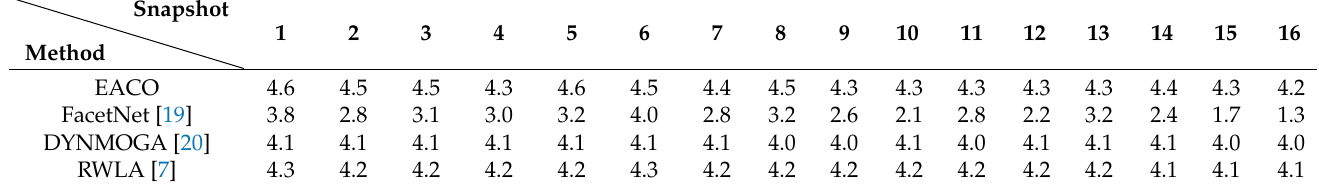
Table 4. Average frequency of OD pairs between road segments within the same community.